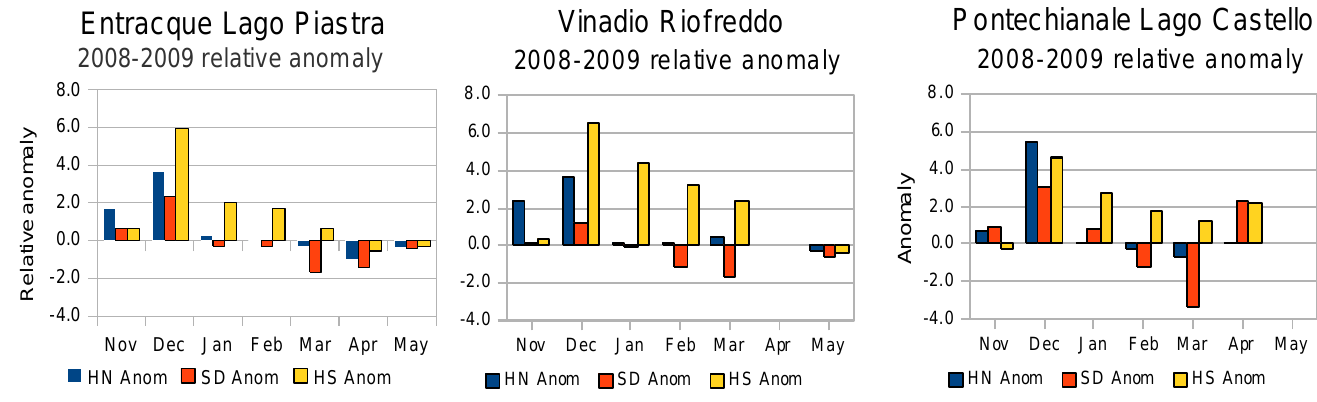
Figure 3. The relative anomaly [adimensional] of average monthly cumulated snowfall (HN), snowy days (SD), and snow depth (HS), for the period 2008–2009, compared with the reference period 1971 – 2000. April and May anomalies are not available for Vinadio Riofreddo and Pontechianale Lago Castello,